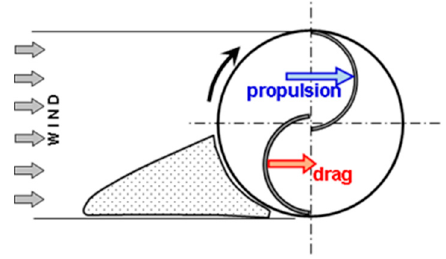
Figure 5. Shielding of Savonius rotor.